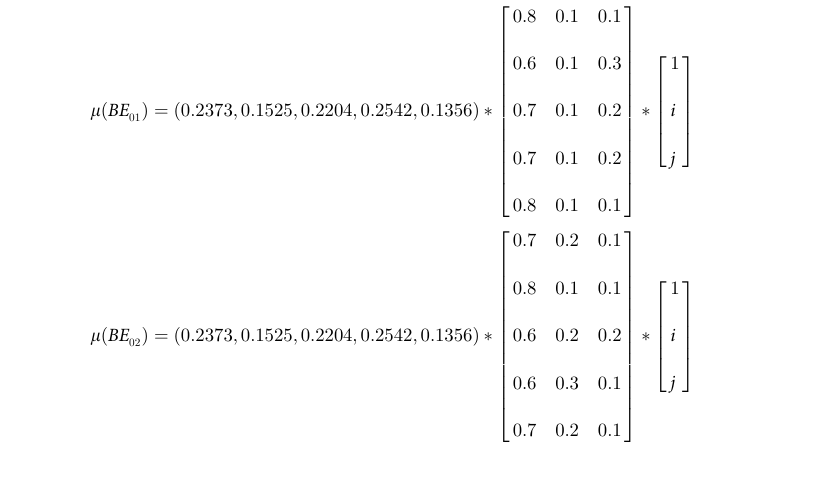
Table 4. Connection number of the